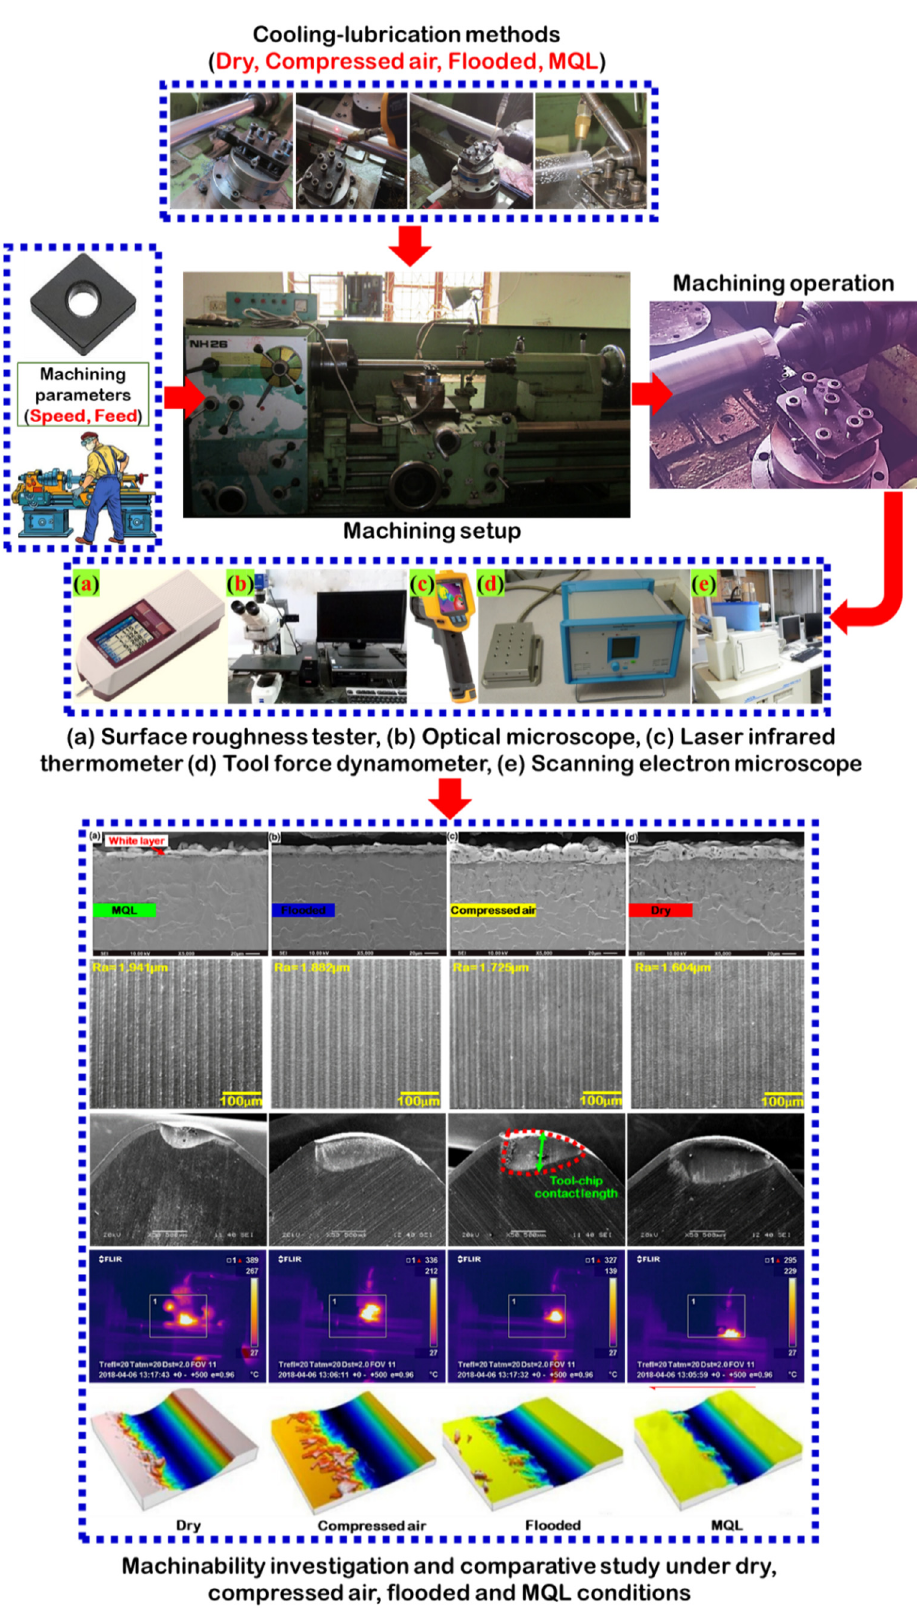
Figure 3. Graphical illustration of experimental setup and discussion of results. Adapted from